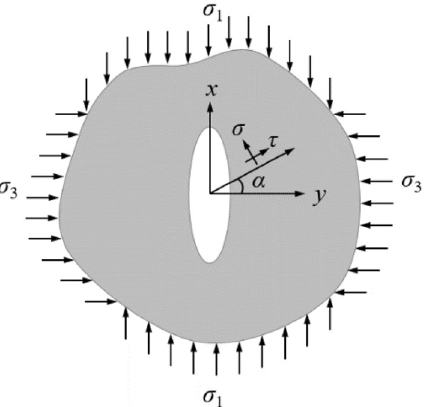
Figure 11. Crack analysis model based on fracture criterion of crack